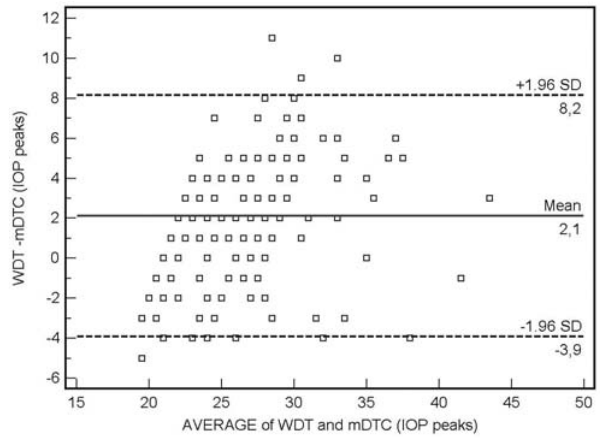
Figure 3 - Agreement between the WDT and mDTC